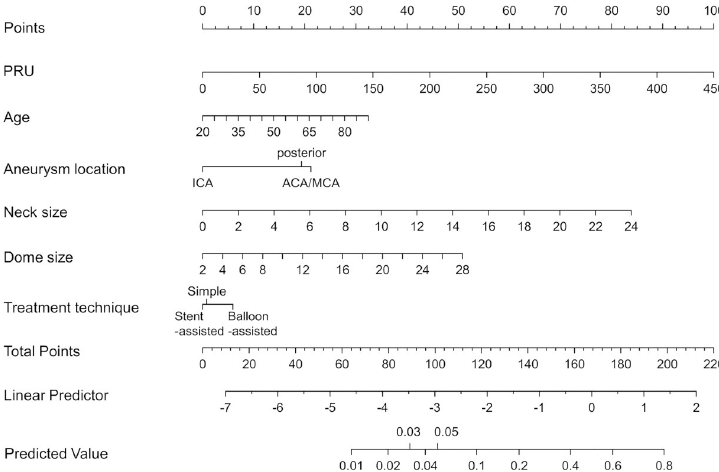
Fig 6. Nomogram that predicts the occurrence of TE during/after coil embolization of UIA using the clinical + PRU model. Abbreviations: TE, thromboembolic event; PRU, P2Y 12 reaction units; UIA, unruptured intracranial